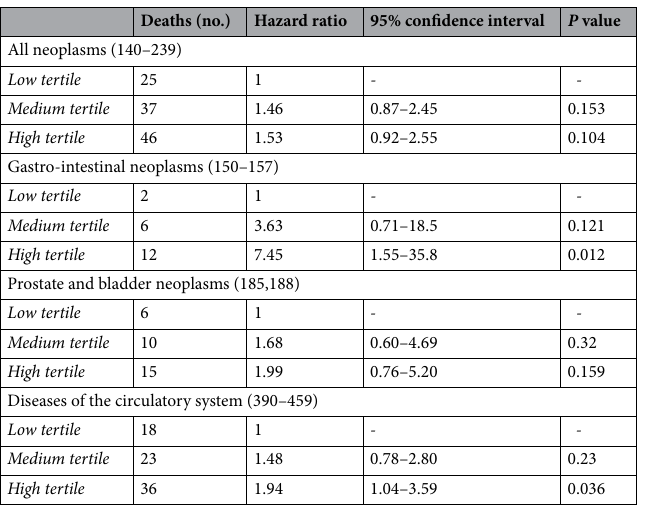
Table 6. Mortality risk by selected causes of death and tertile of DNA damage measured with the comet assay (composite endpoint). The hCOMET cohort. Estimates adjusted for age, sex, smoking habit, and occupational exposure. In brackets ICD-9 (International Classification of Diseases-9)